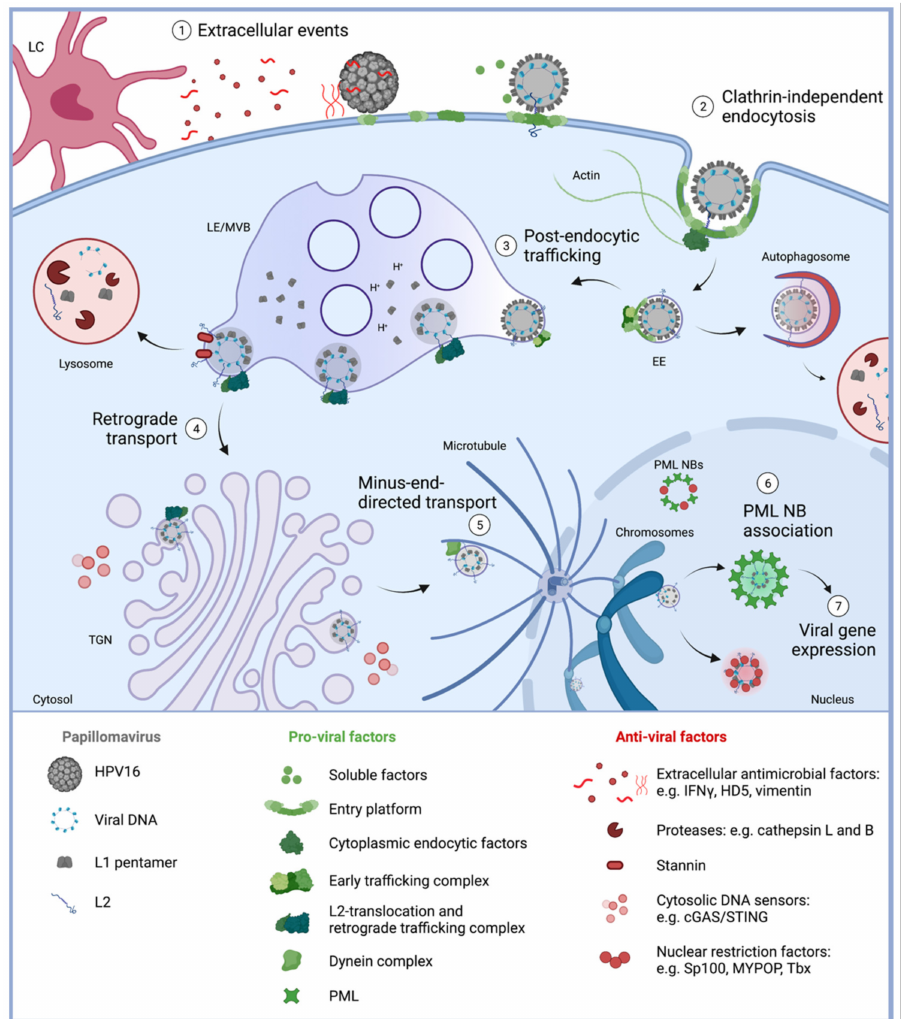
Figure 1. Diagram of HPV16 entry into their host cells with a focus on host restriction